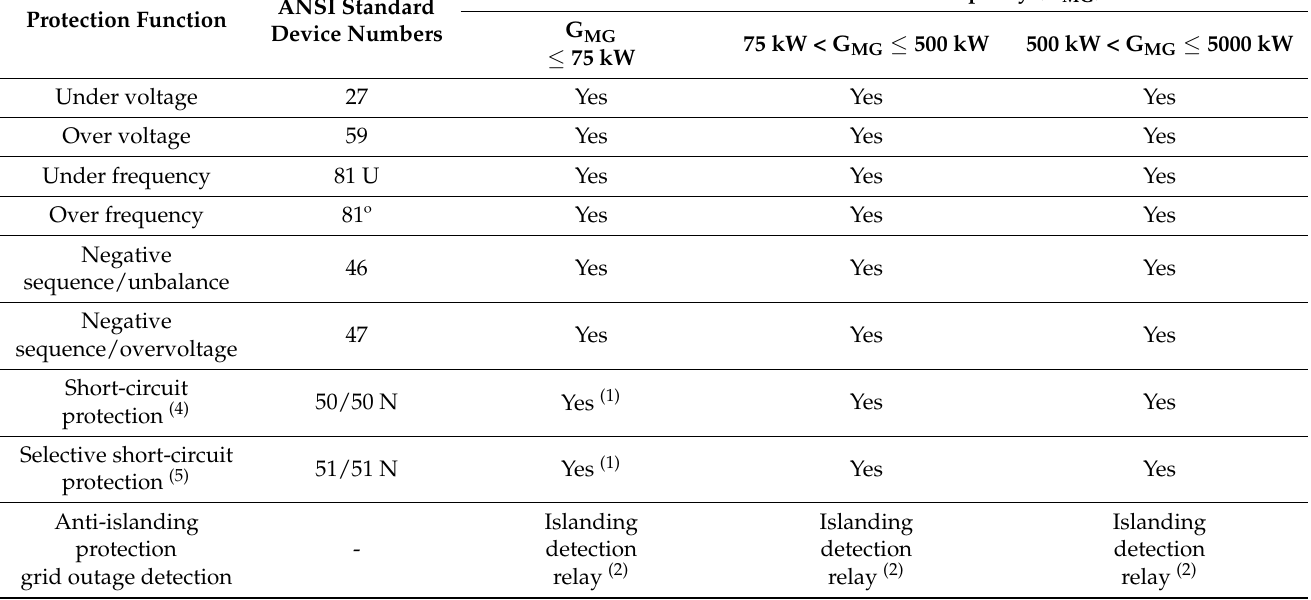
Table 5. Requirements for distributed generation connection at the distribution grid. Protection functions for DG up to 5 MW (microgeneration or mini-generation), according to ANELL Normative N ◦ 1059